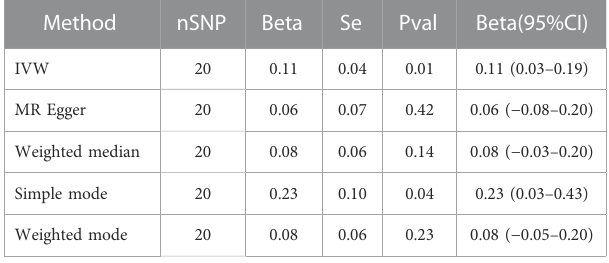
TABLE 3 Shows the Mendelian randomization analysis between COVID-19 severity (severe respiratory symptoms) and cardiac injury